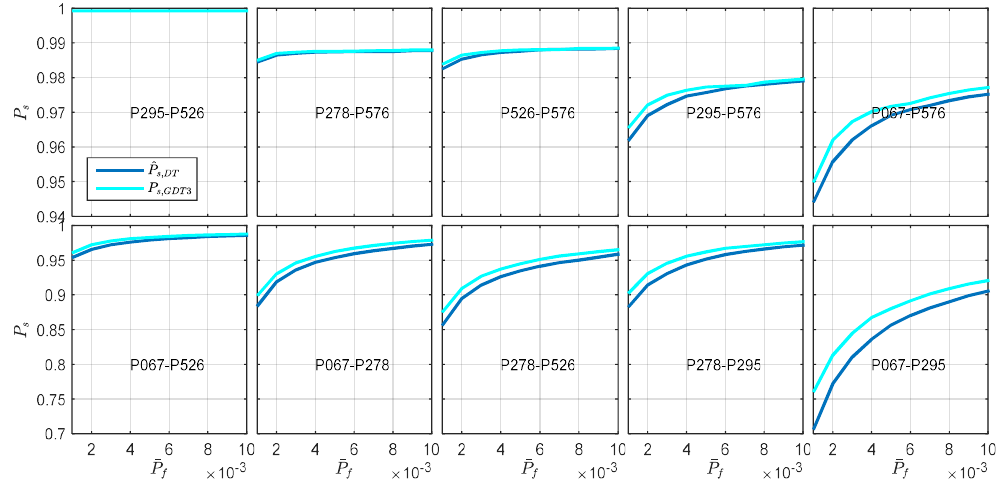
Figure 10 . Illustration of the empirical success rates of DT and GDT3 test statistics. Figure 10. Illustration of the empirical success rates of DT and GDT3 test